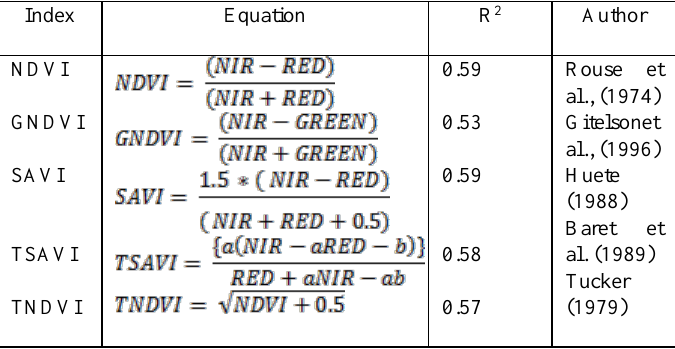
Table 4. Comparison between Biomass Estimation Methods.